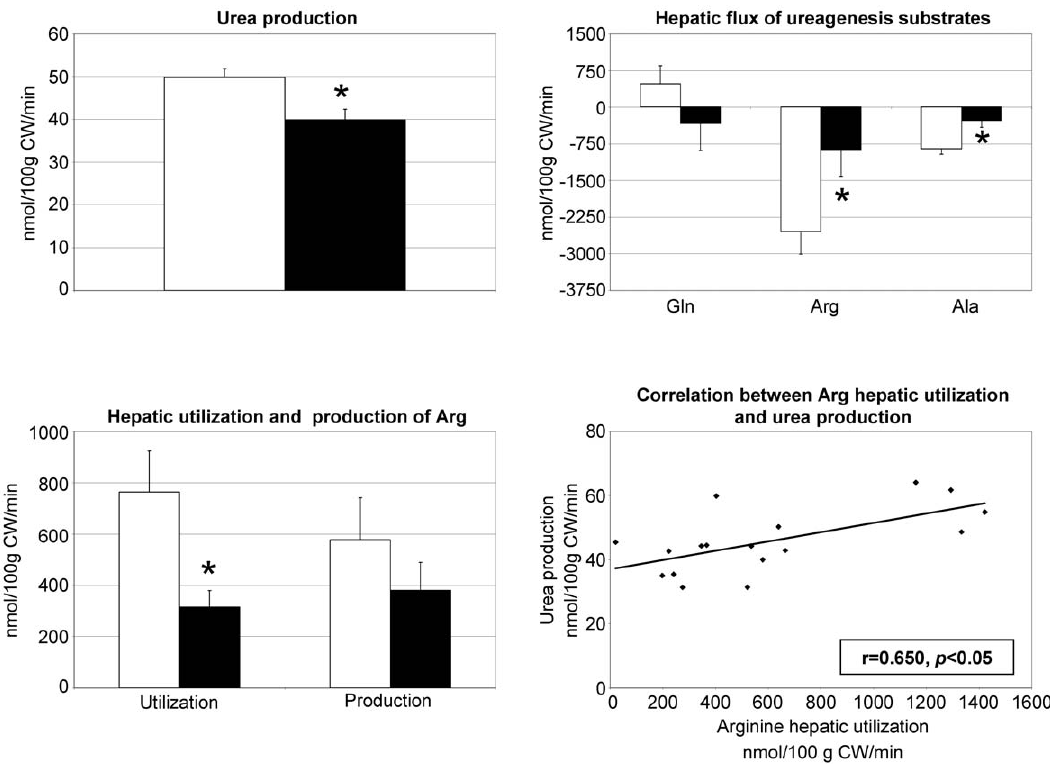
Figure 3. Effect of aging on urea production and hepatic metabolism of major substrates of ureagenesis, i.e. arginine and alanine. CW=carcass weight. % adult rats and & old rats. Values are expressed as means 6 SEM. * P , 0.05 vs . adult group (Student’s t -test). doi:10.1371/journal.pone.0027002.g003 PLoS ONE |